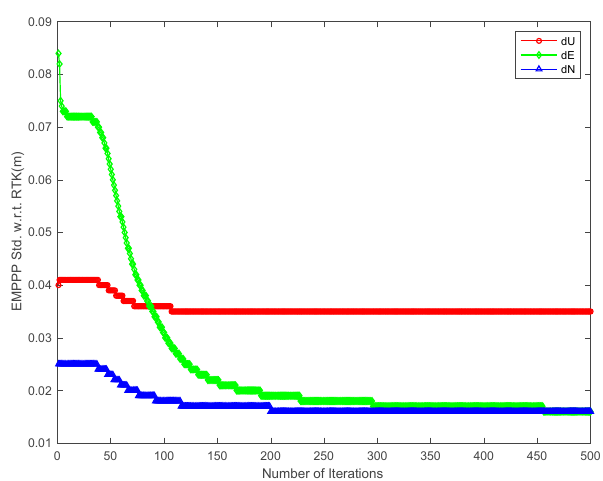
Figure 11. EM-PPP STDs w.r.t. RTK solution in Up, East and North (unit: m).